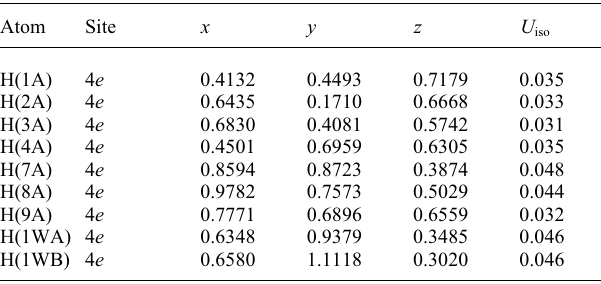
Table 2. Atomic coordinates and displacement parameters (in Å 2 )